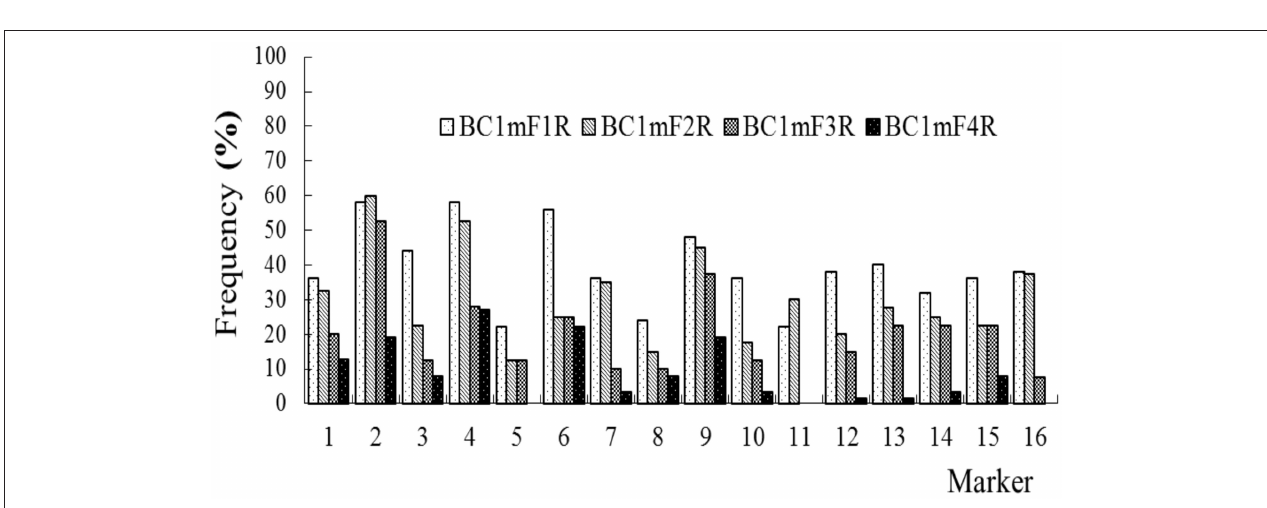
FIGURE 9 | Frequency of the marker specific to the C-chromosome of Brassica napus in the first (BC1mF1R)- to fourth (BC1mF4R)-generation progenies of BC1. BC1mF1 R to BC1mF4R are the glyphosate-tolerant first- to fourth-generation progenies of the first backcross generation (BC1) obtained from wild Brassica juncea × F1R. F1R indicates the glyphosate-tolerant F1 hybrids obtained from wild B. juncea × glyphosate-tolerant transgenic oilseed rape. Progenitors in front of the × are always the maternal plants, and progenitors after the × are always the paternal plants. high genetic diversity of wild B. juncea in natural environments conducted on the effects that genotypes both from transgene may complicate the genome evolution of hybrids (Dong oilseeds rape and from wild B. juncea have on the evolution of et al., 2018; Sun et al., 2018). Further research should be